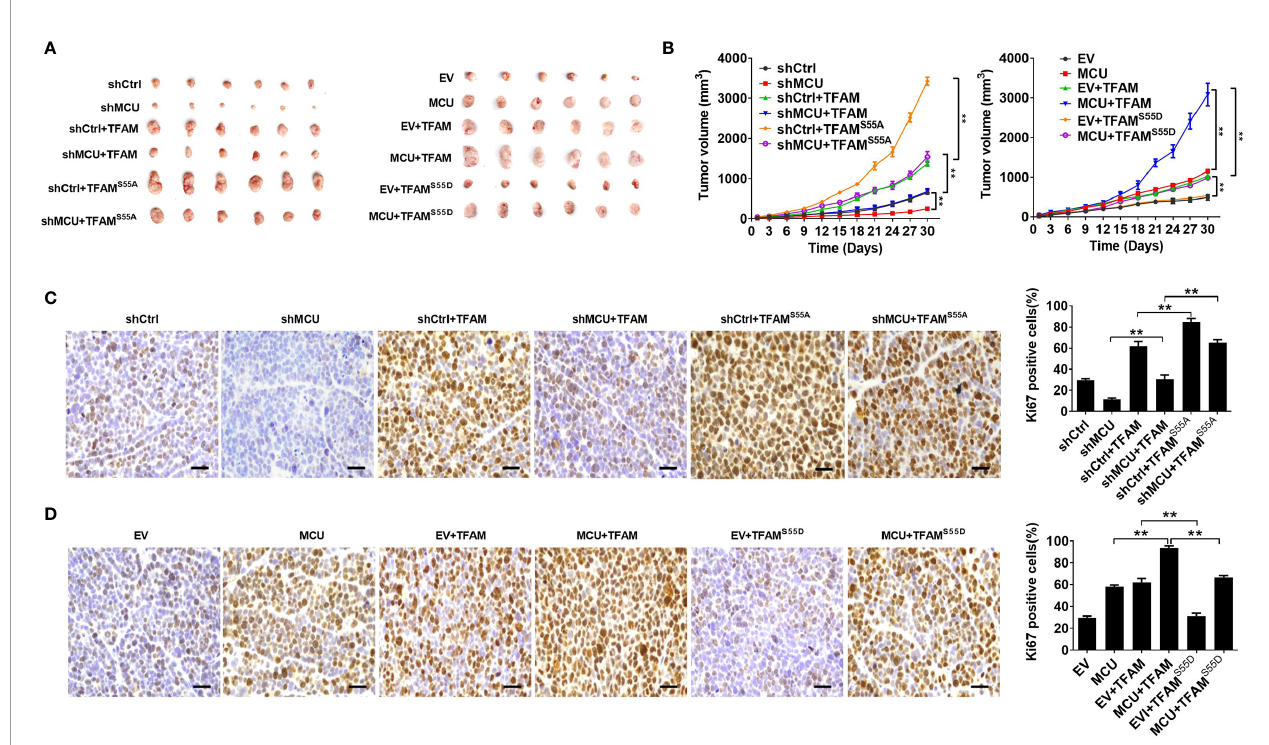
FIGURE 6 | Decreased phosphorylation of TFAM is involved in mitochondrial Ca2+-mediated CRC growth in vivo . (A) Dissected tumors from sacri fi ced mice and (B) tumor growth curves of subcutaneous xenograft tumor developed from LS174T cells with treatments as indicated. (C, D) Representative IHC staining images of Ki67 and (shMCU and MCU group) percentage of Ki67-positive cells in xenograft tumor developed from LS174T cells with treatments as indicated (scale bar, 50 m m). ** P <